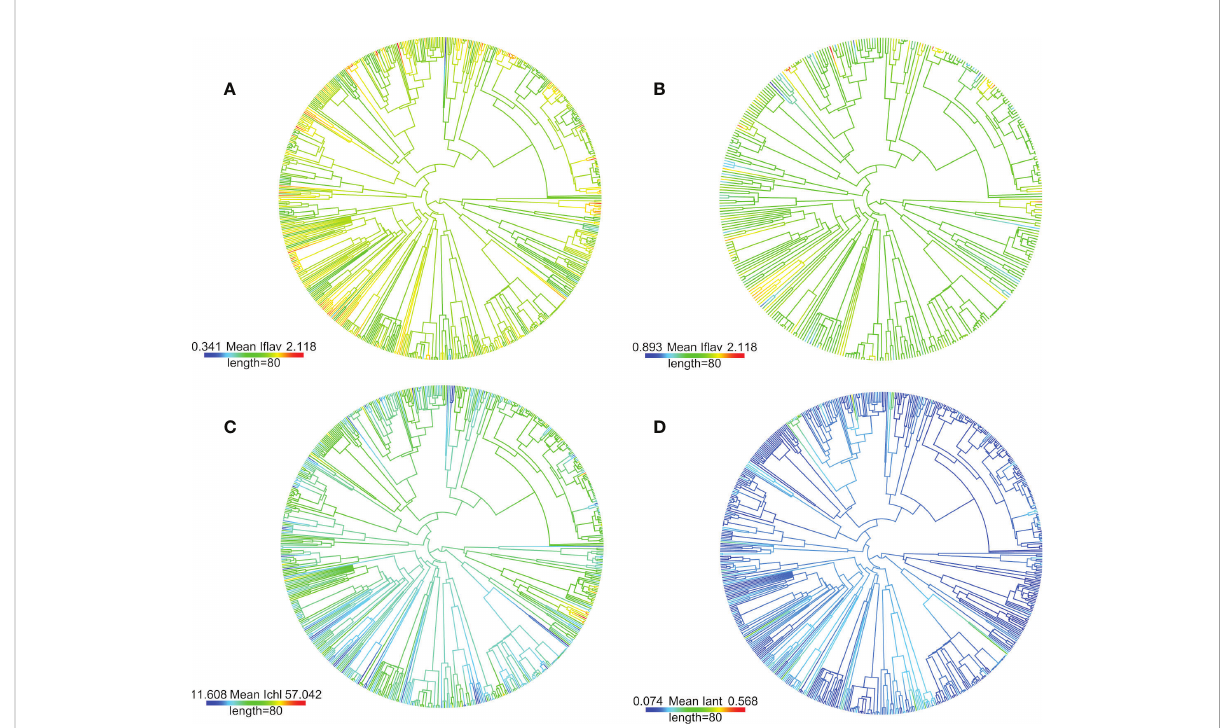
FIGURE 2 Used phylogeny for the studied 622 taxa from the alpine botanical garden (Col du Lautaret, French Alps) based on previously published mega- tree (GBOTB.extended.tre) and methodology (scenario 1) from Jin and Qian (2019), is plotted with mean leaf trait values (I fl av = A & B , I chl = C and I ant = D ) as colour scale by using R package phytools (Revell, 2012 and Revell, 2013). Colour bar length is a scale for branch lengths (million years, Myr). The plotting method estimates ancestral trait values but estimate of uncertainty is not shown, and ancestral values are mainly shown for visual clarity. The (B) panel shows mean I fl av of taxa with no plants from shaded microhabitats (categorised light condition maximum of minor shade over day) with differing scale of values. Infraspeci fi c taxa (i.e. subspecies and variety) were included in the phylogeny by combining them with their parental species. High-quality pdf -versions with tip labels may be found at the end of the Supplementary